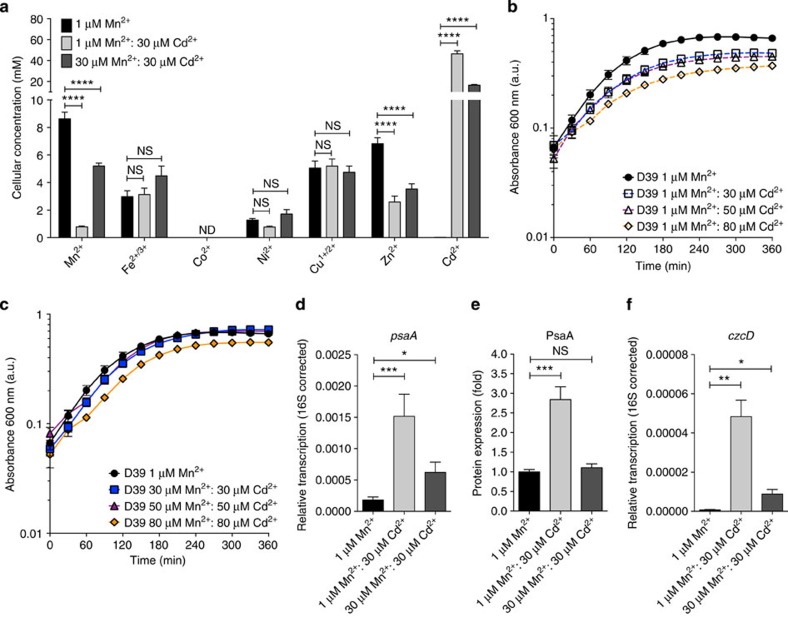
Impact of Cd2+ on S. pneumoniae growth and first row transition metal homeostasis.(a) Total cellular metal ion accumulation of S. pneumoniae represented as the mean (±s.e.m.) concentration of ions per cell (determined as c.f.u.) of known cell volume (determined by scanning electron microscopy (SEM)) grown in the specified conditions. The values represent the total cellular metal ion quota, that is, bound, buffered and unbound metal ions, and are from at least three independent biological experiments. Metal ions assessed were Mn2+, Fe2+/3+, Co2+, Ni2+, Cu1+/2+, Zn2+ and Cd2+. The statistical significance of the differences in the mean metal concentrations was determined by a one-way ANOVA (ND, not detected; NS, not significant and ****P<0.0001). (b,c) S. pneumoniae (D39) grown in CDM supplemented with metal ions as indicated. The data correspond to mean (±s.e.m.) absorbance at 600 nm measurements from three independent biological experiments. Errors bars, where not visible, are overlapped by the representative symbols. (d) Relative transcription, corrected to 16S rRNA, of psaA by S. pneumoniae when grown in CDM supplemented with 1 μM Mn2+ (black), 1 μM Mn2+: 30 μM Cd2+ (light grey) and 30 μM Mn2+: 30 μM Cd2+ (dark grey). (e) Quantitative immunoblot data of PsaA (Supplementary Fig. 2), from equivalent total protein loadings of whole-cell extracts, from S. pneumoniae when grown in CDM supplemented with 1 μM Mn2+ (black), 1 μM Mn2+: 30 μM Cd2+ (light grey) and 30 μM Mn2+: 30 μM Cd2+ (dark grey). (f) Relative transcription, corrected to 16S rRNA, of czcD by S. pneumoniae when grown in CDM supplemented with 1 μM Mn2+ (black), 1 μM Mn2+: 30 μM Cd2+ (light grey) and 30 μM Mn2+: 30 μM Cd2+ (dark grey). The data correspond to the mean (±s.e.m.) of three independent biological experiments. The statistical significance of the differences in the mean data was determined by two-tailed unpaired t-tests (*P<0.05, **P<0.01 and ***P<0.001).